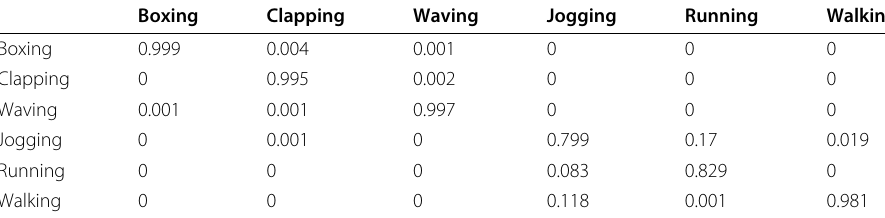
Table 4 ResIncConvLSTM architecture confusion matrix on KTH